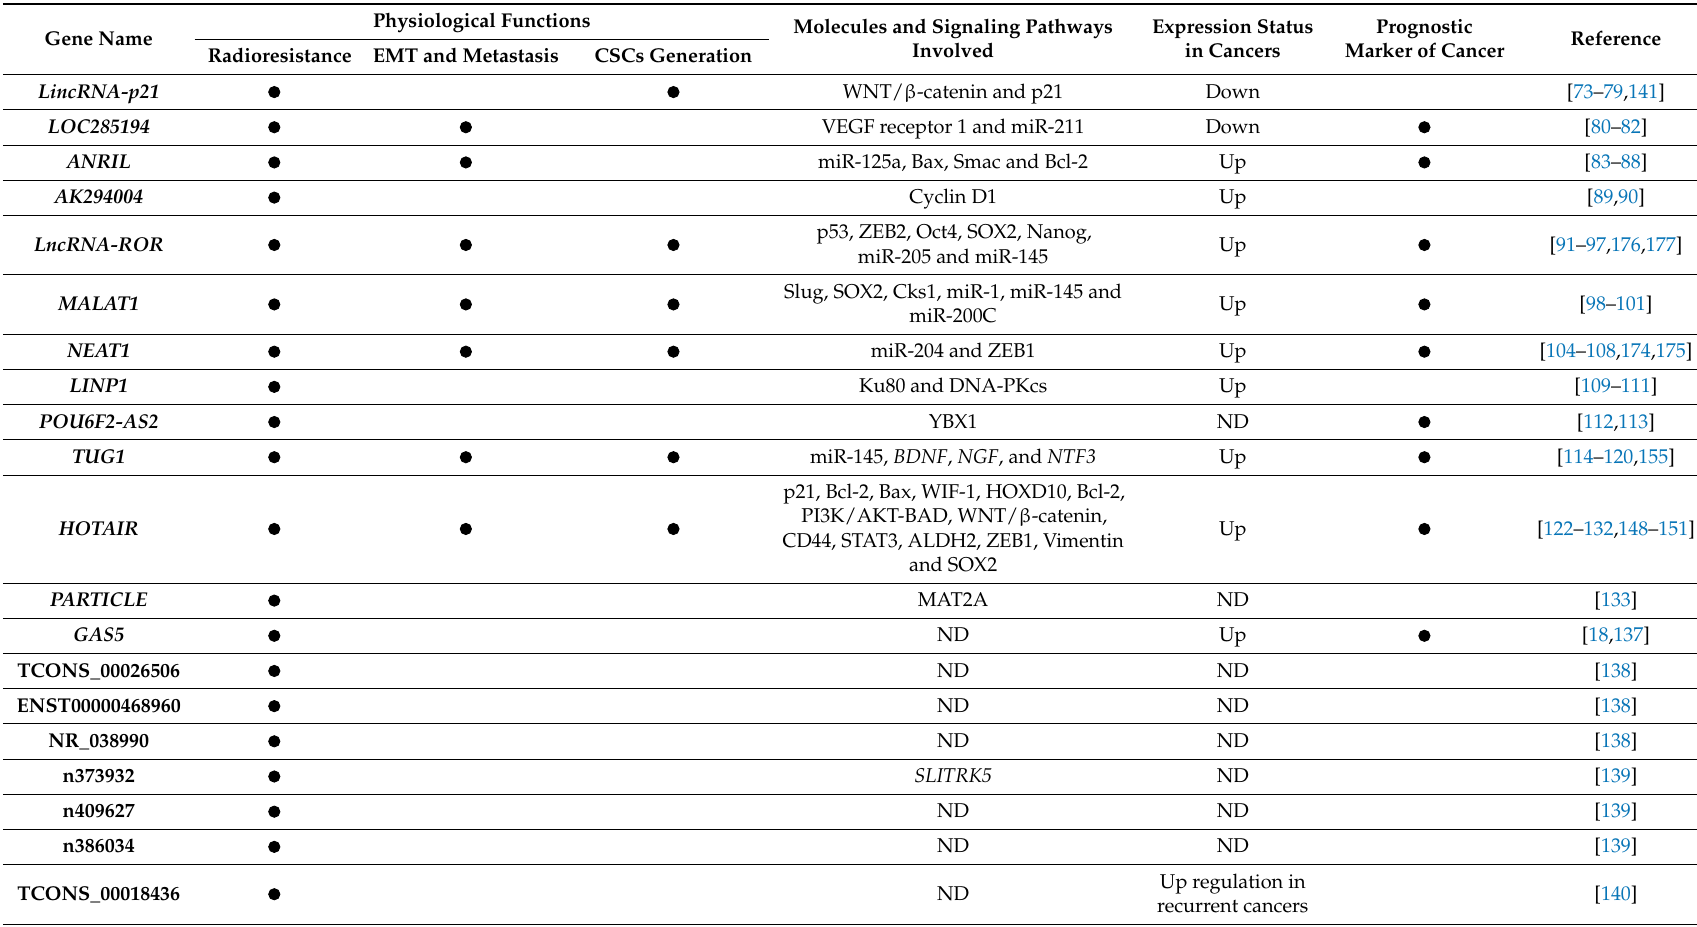
Table 1. Summary of the relevant long noncoding RNAs (lncRNAs) in radioresistance, epithelial–mesenchymal transition (EMT)/metastasis and cancer stem cells (CSCs) generation in